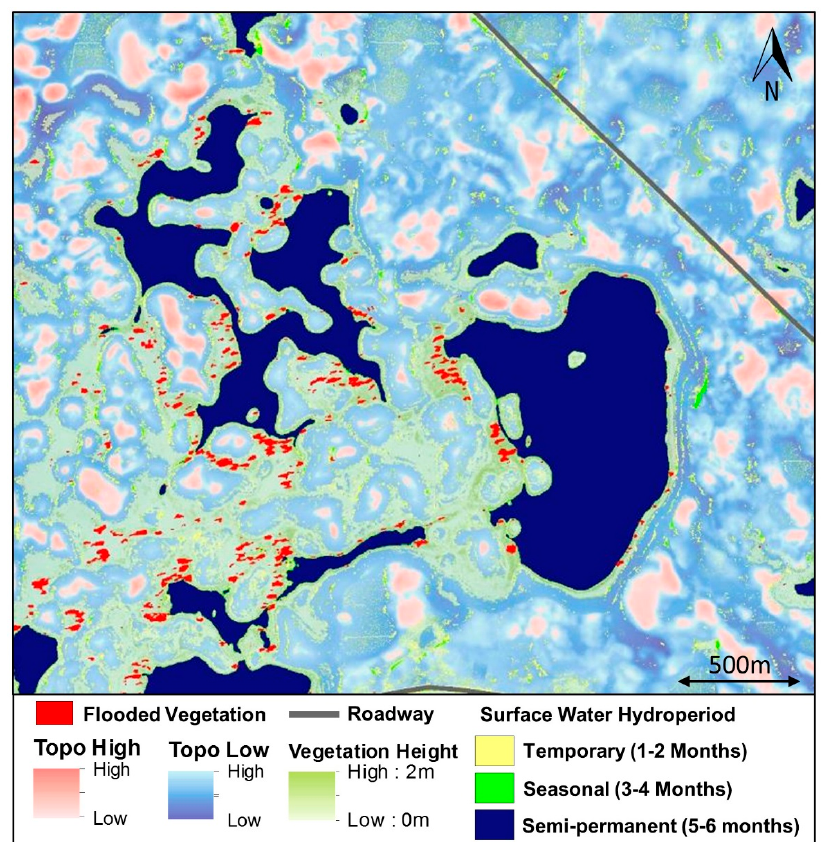
Figure 8. Complete data fusion product in the URSA region showing all wetland attributes and characteristics derived from the decision-based data fusion methodology. Remote Sens. 2019 , 11 , x FOR PEER REVIEW